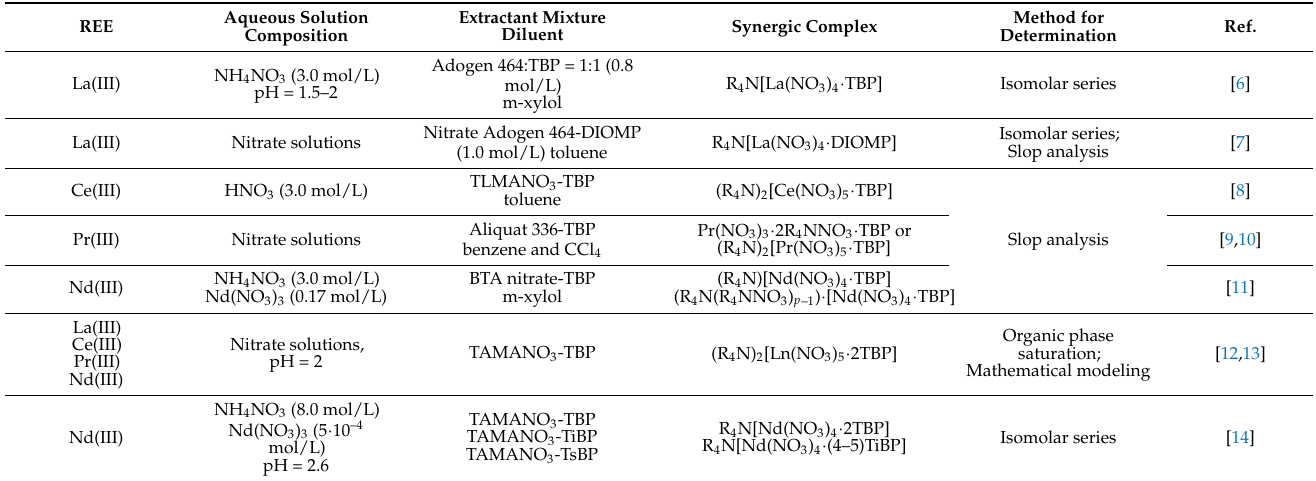
Table 1. Separation of rare-earth elements from aqueous nitrate solutions by solvent extraction techniques. Synergic Complex Method for Determination